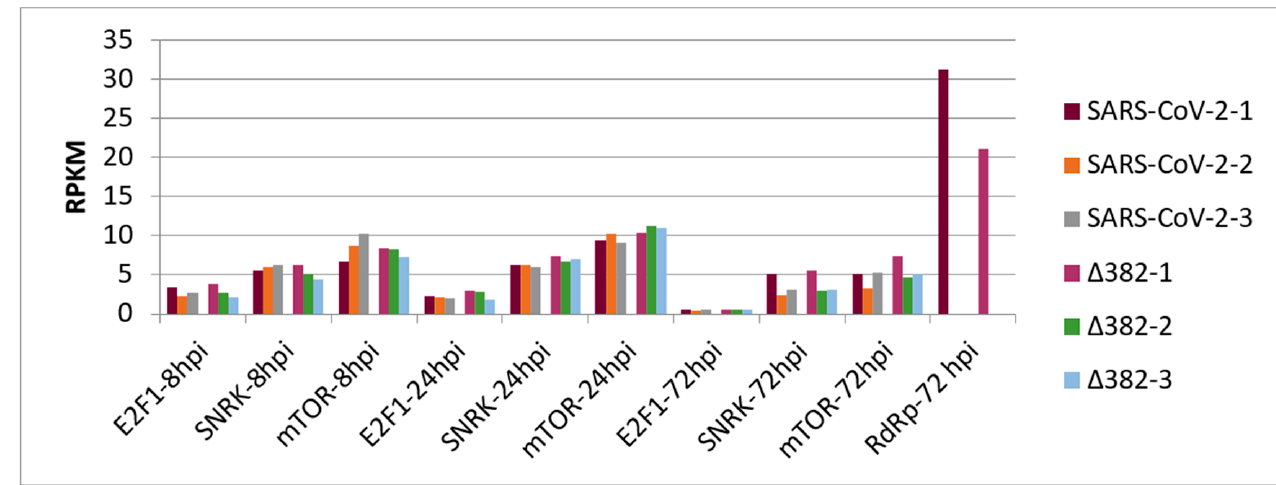
Figure 3. Transcript accumulation of E2F1, SNRK and mTOR in human nasal epithelial cells infected by two SARS-CoV-2 variants at 8 hpi, 24 hpi and 72 hpi and transcript levels of RdRp (×0.5) at 72 hpi for cell origin 1.